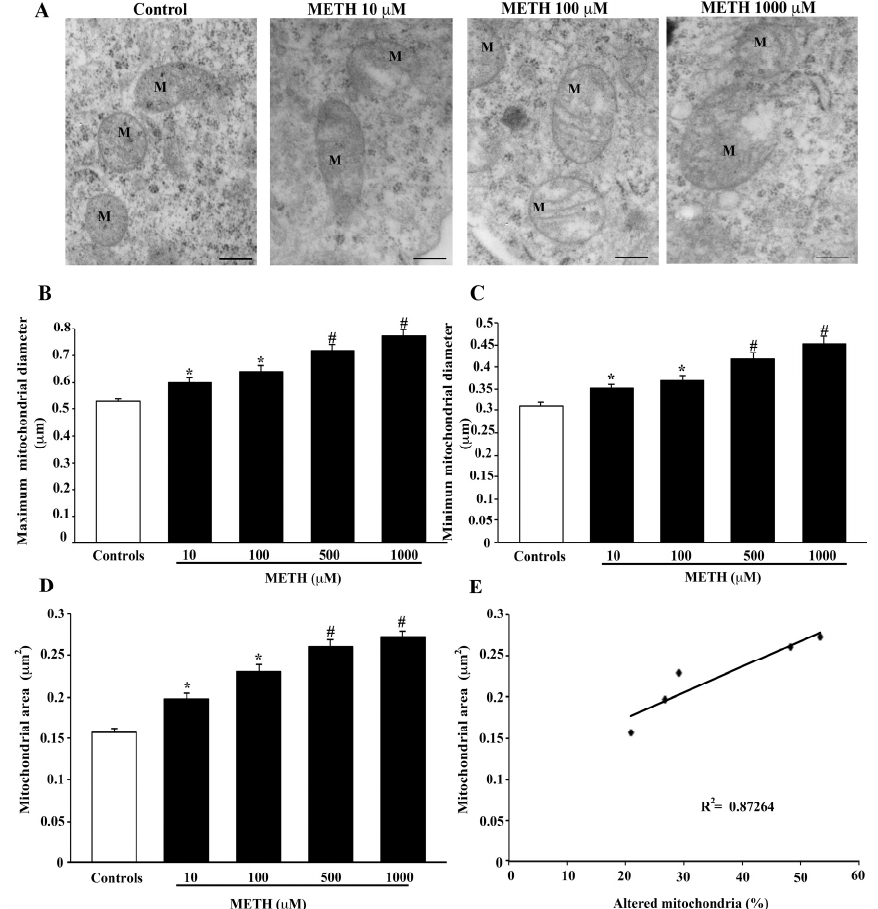
Figure 7. METH modifies mitochondrial size. ( A ) Representative TEM micrographs showing dose- dependent mitochondrial (M) changes induced by METH. Graphs report the maximum ( B ), and the minimum ( C ) mitochondrial diameter and the mitochondrial area ( D ). The graph reports the linear regression ( E ) between the mitochondrial area and the percentage of altered mitochondria for various doses of METH ( p = 0.02). Values are given as the mean ± S.E.M from N = 150 mitochondria per group. * p ≤ 0.05 compared with controls; # p ≤ 0.05 compared with controls and METH 10 µ M and 100 µ M. Scale bars = 160